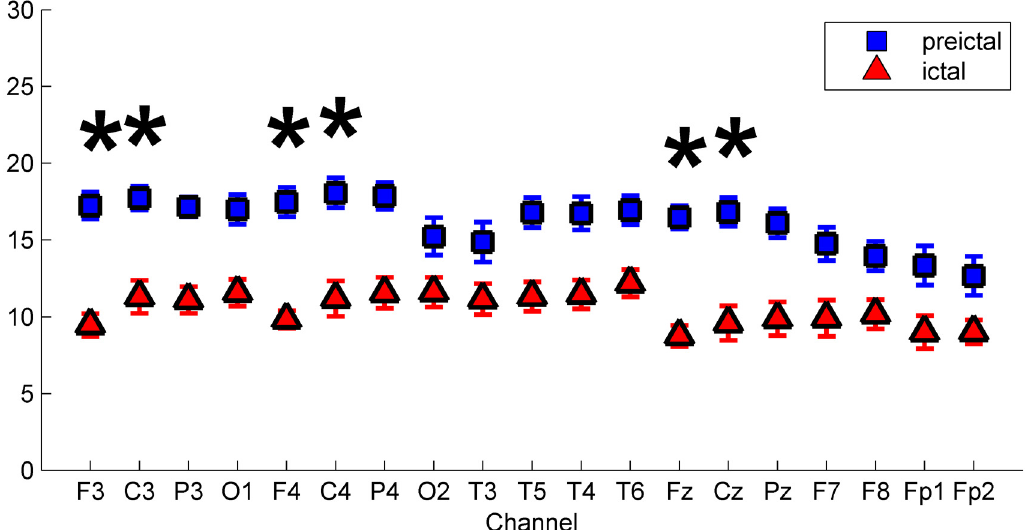
Fig 4. The mean of complexity index (CI) in pre-ictal and ictal states in all patients with sampling frequency of 1000Hz. Comparing CI changes in the pre-ictal and ictal states in the occipital areas, the changes were significantly larger in F3, F4, Fz, C3, C4, and Cz. The error bars were standard errors. * p < 0.01.